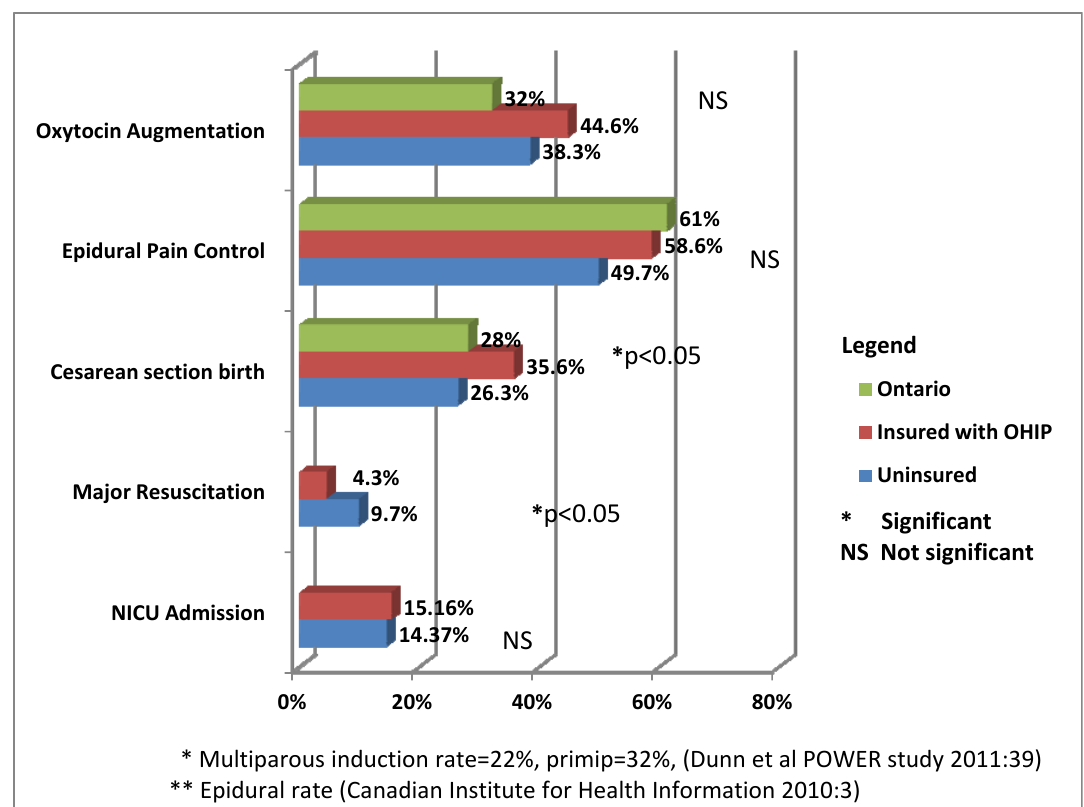
Figure 4. Rates of medical interventions by insurance status ( n = 453) and in general